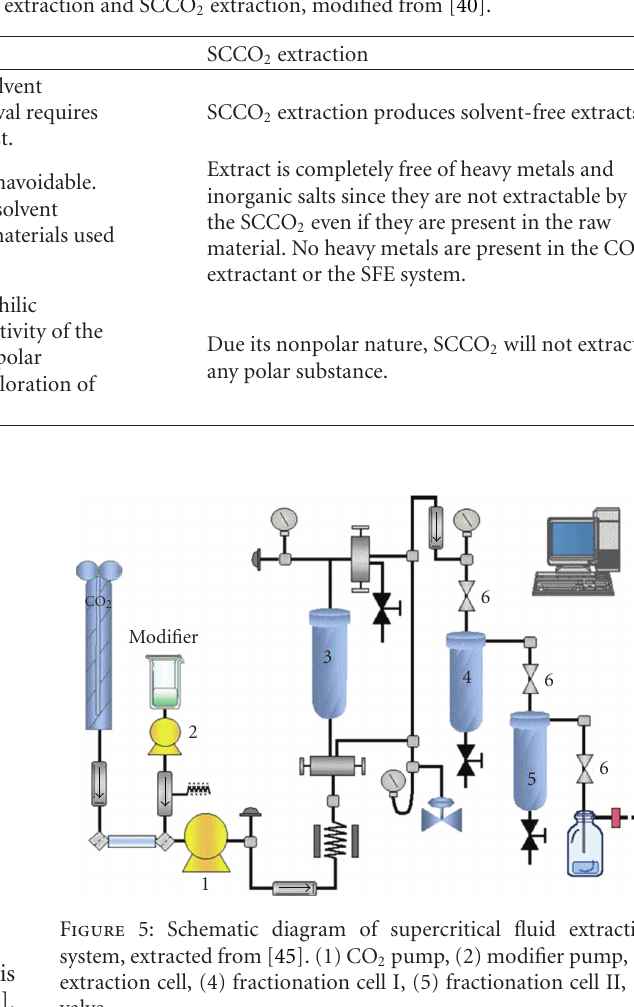
Table 3: Comparison between organic solvent extraction and SCCO 2 extraction, modified from [40].